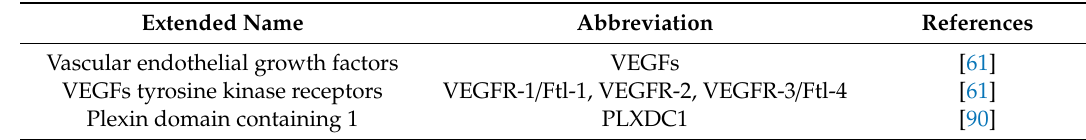
Table 3. Molecular targets implicated in angiogenesis.